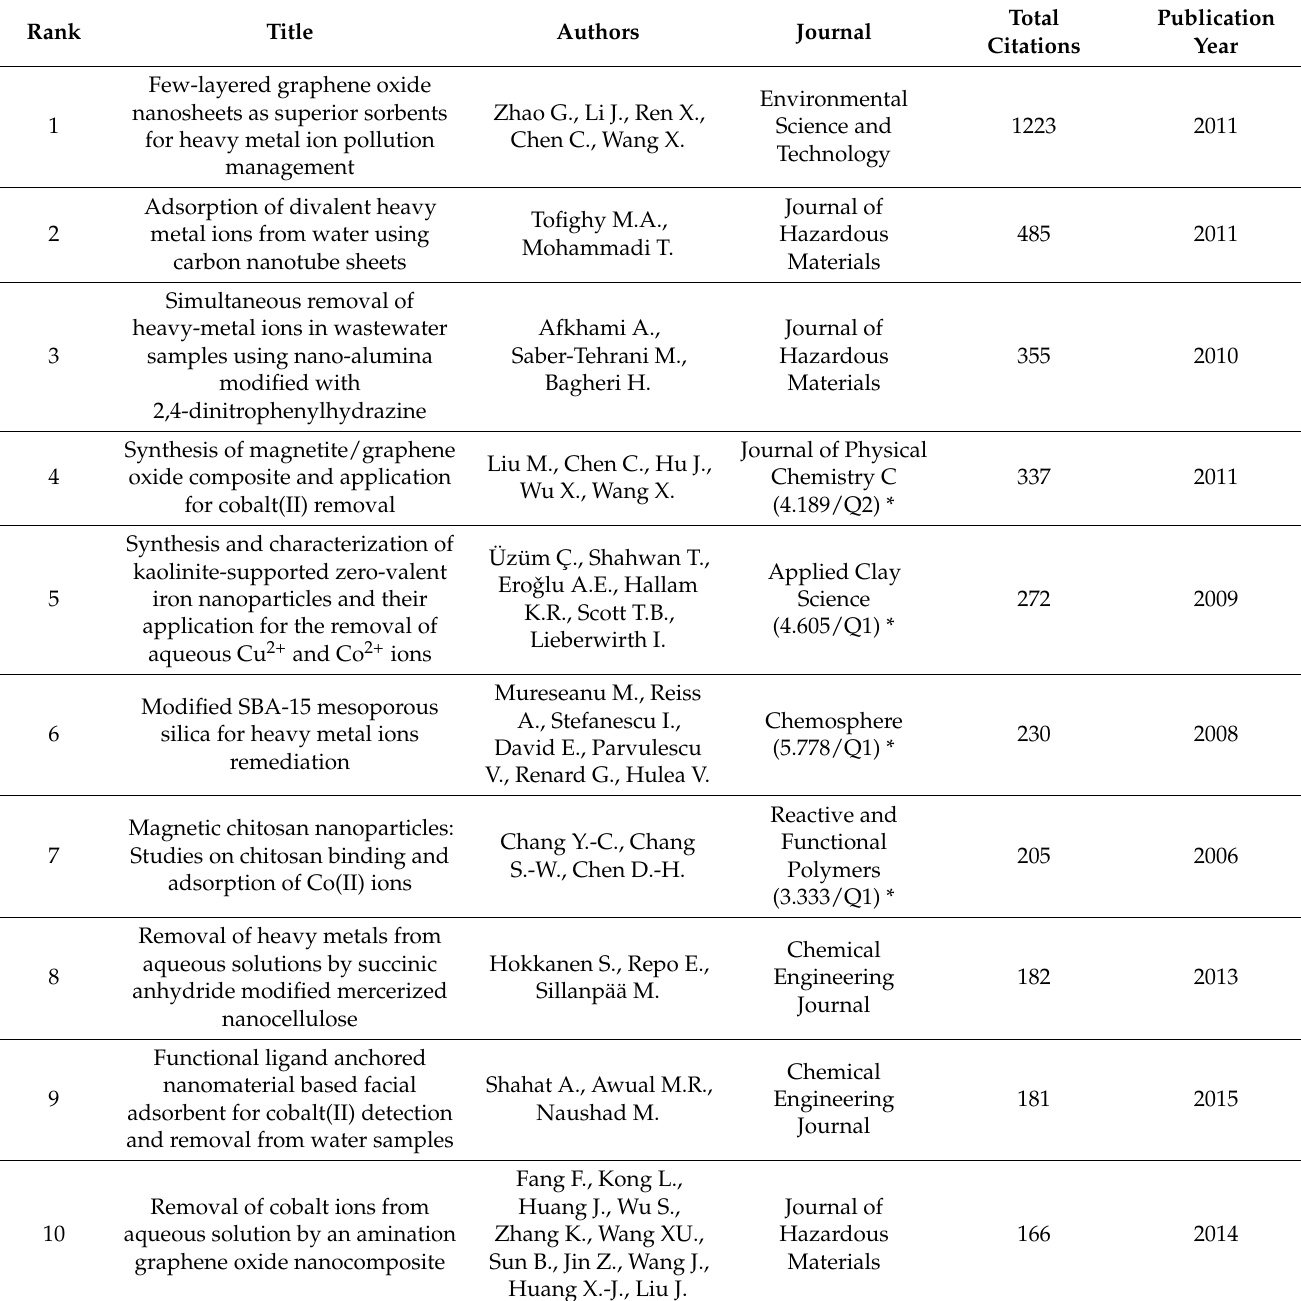
Table 6. Top 10 cited research